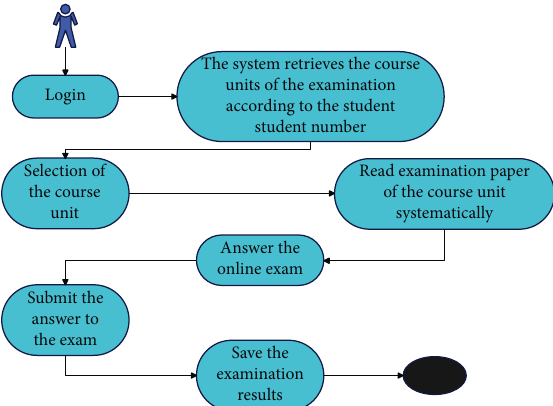
Figure 4: Activity diagram of students taking online